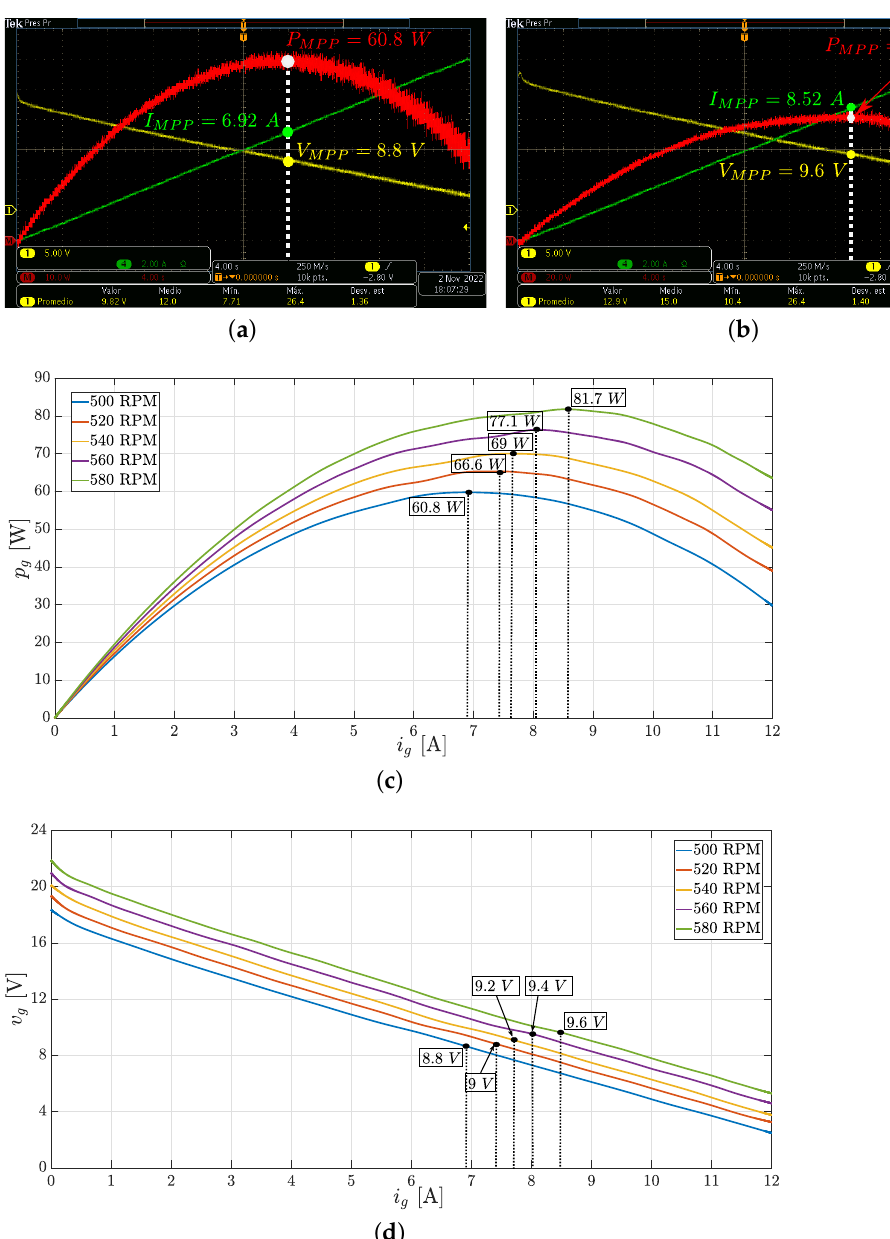
Figure 2. Power, voltage and current curves for several angular speeds. ( a ) Test at 500 RPM. ( b ) Test at 580 RPM. ( c ) Power vs. Current curves of the WTGS. ( d ) Voltage vs. Current curves of the